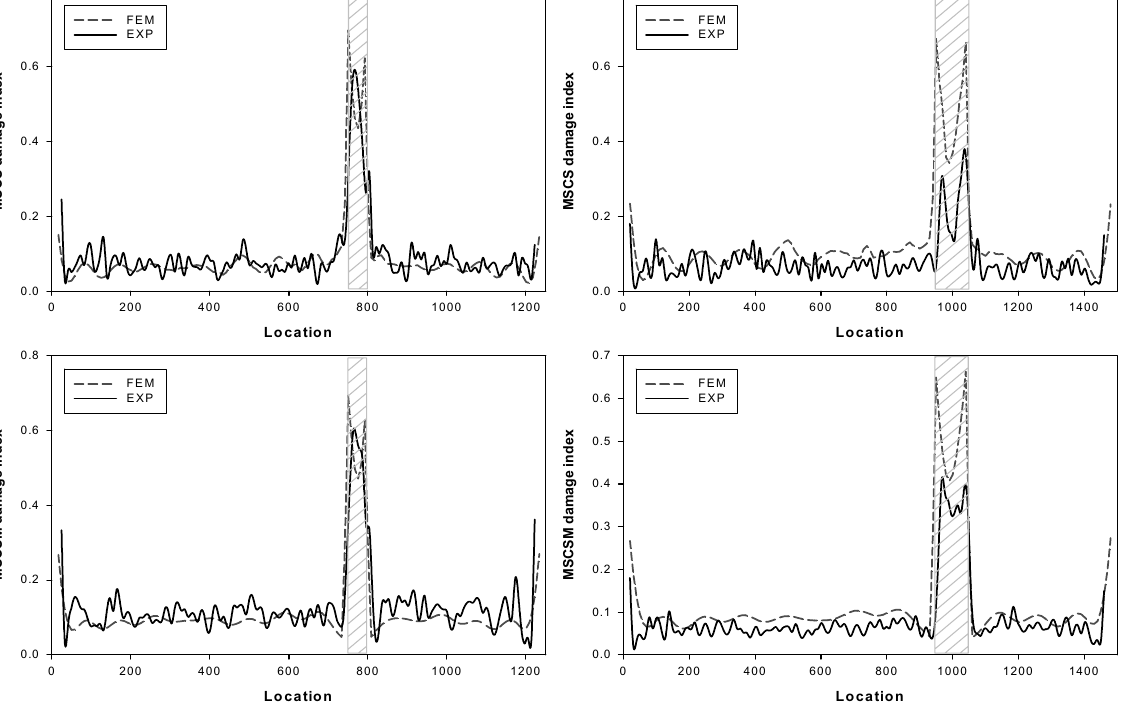
Fig. 4. Damage detection methods for beams with CL boundary conditions; Beam1 – left; Beam 2 –